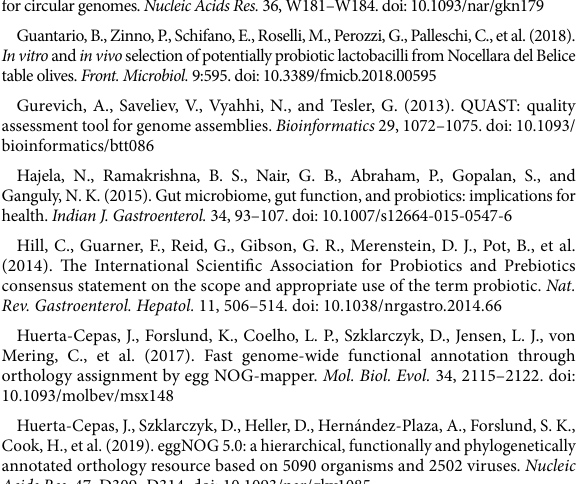
table olives. Front. Microbiol. 9:595. doi: